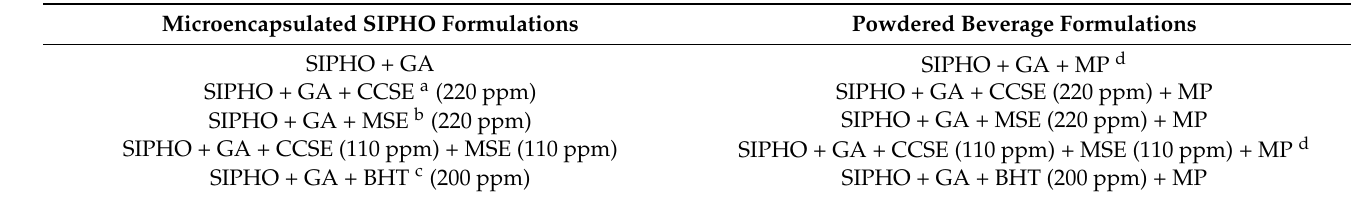
Table 1. Formulations of sacha inchi Plukenetia huayllabambana oil (SIPHO) microencapsulated and powdered